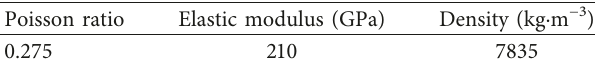
Table 2: Material parameters of